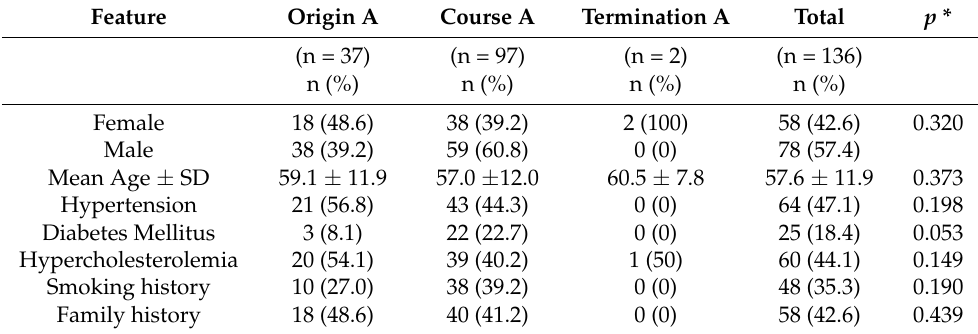
Table 3. Demographic characteristics and coronary risk factor status of patients with coronary artery